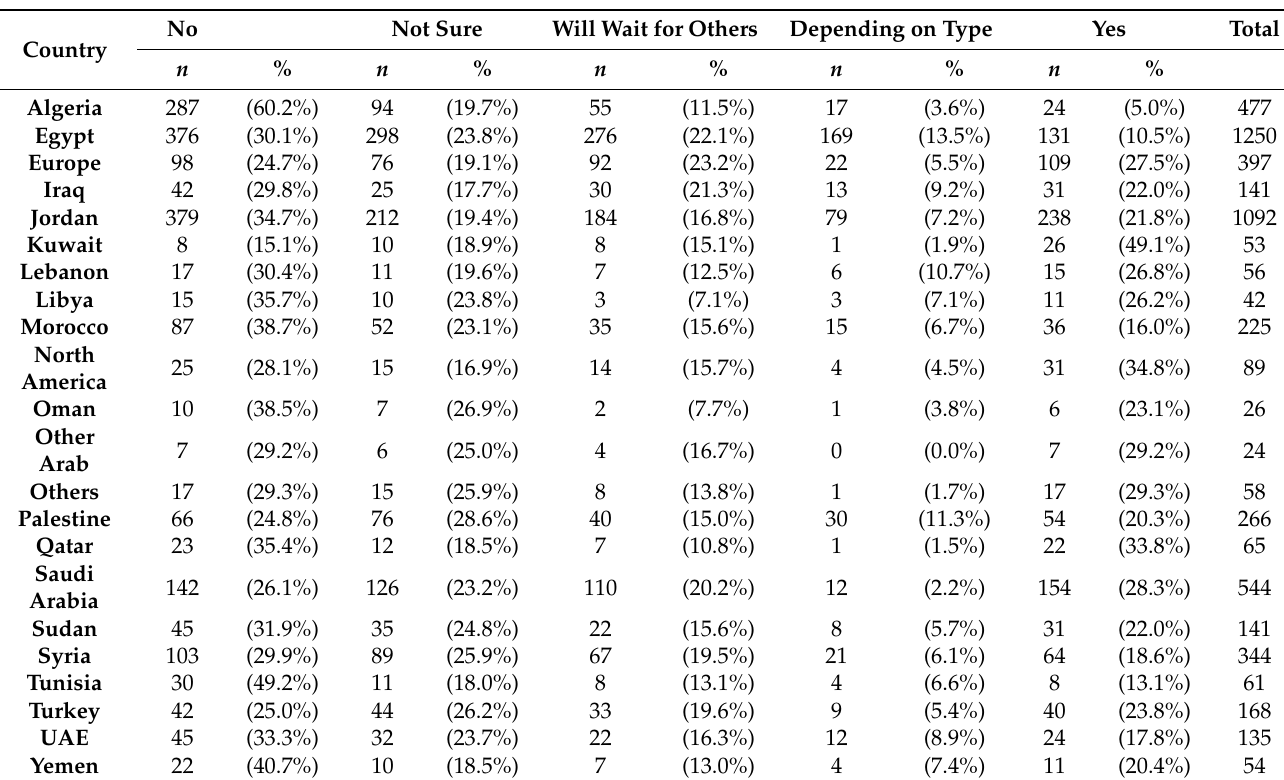
Table 1. Acceptance and Hesitancy Rates by